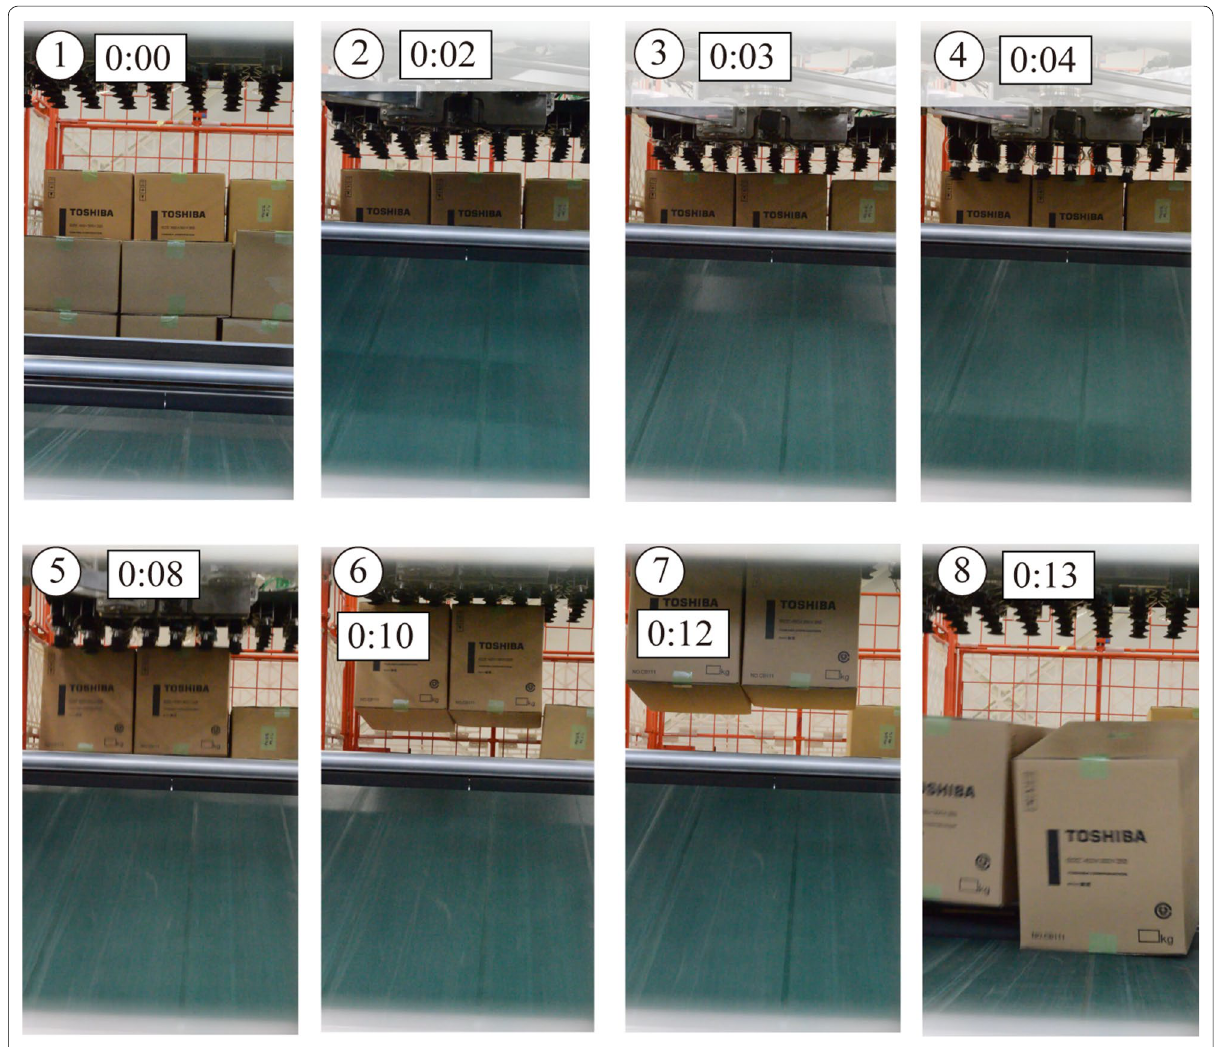
Fig. 35 Part of the verification operation (extracting two cardboard boxes)